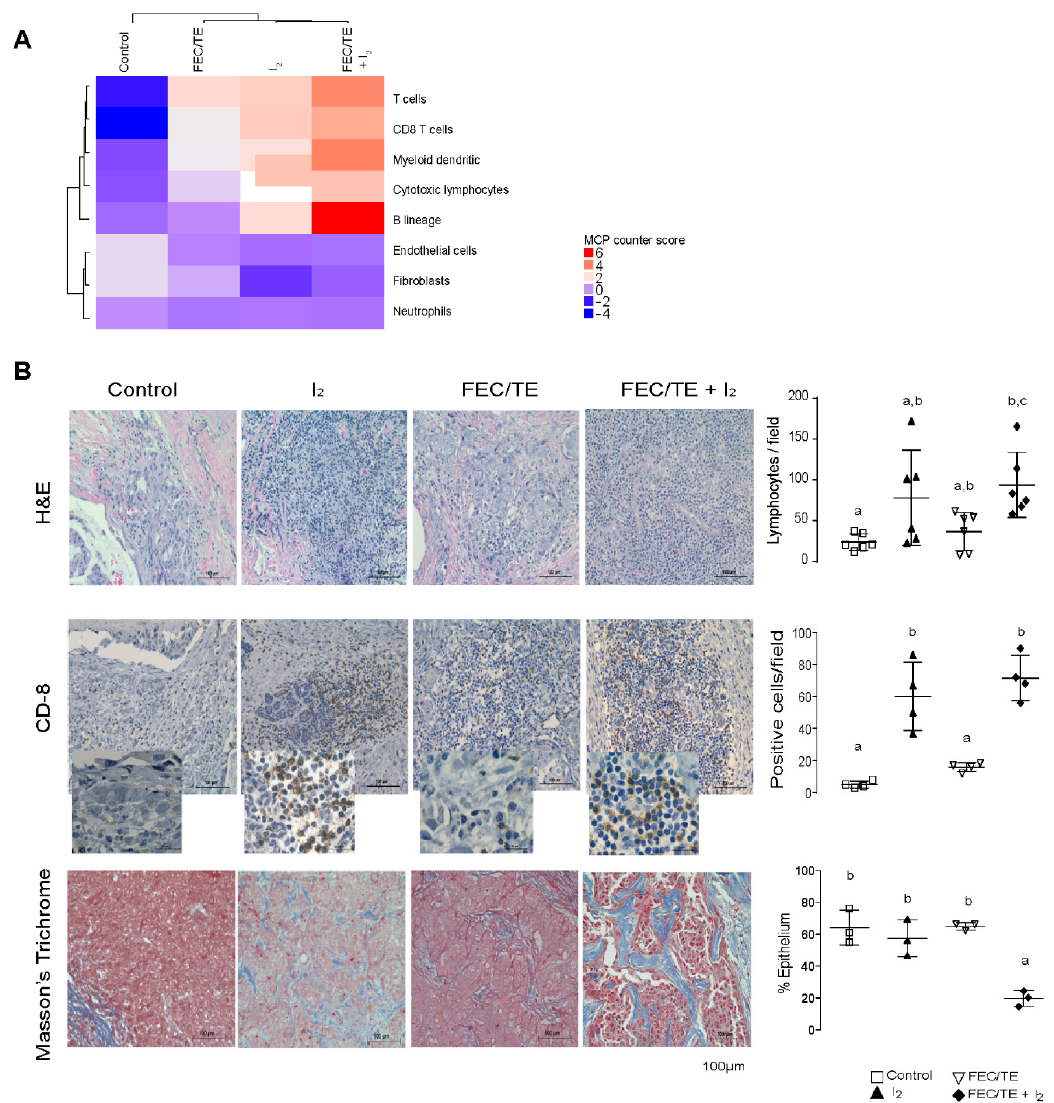
Figure 6. Immune signature and di ff erential response of epithelial and lymphocytic infiltration after I 2 treatment. ( A ) Abundance of different cell populations was calculated by the MCP-counter method, based on a gene expression matrix of the distinct experimental groups. Hierarchical clustering of experimental groups. ( n = pool of four individual tumors per experimental group. Duplicated pools per group were used for gene expression calculation). ( B ) Representative micrograph images of H&E and CD8 immunohistochemistry as well as Masson’s trichromic staining. The graphs on the right show the number of lymphocytes, CD8 + lymphocytes, and Masson’s trichromic positive cells per field. These analyses were performed as the average of three random fields (40 × ), and quantification was performed using ImageJ 1.47. Data are expressed as mean ± SD. Each dot represents an individual sample, and di ff erent letters indicate significant di ff erences between groups ( P <